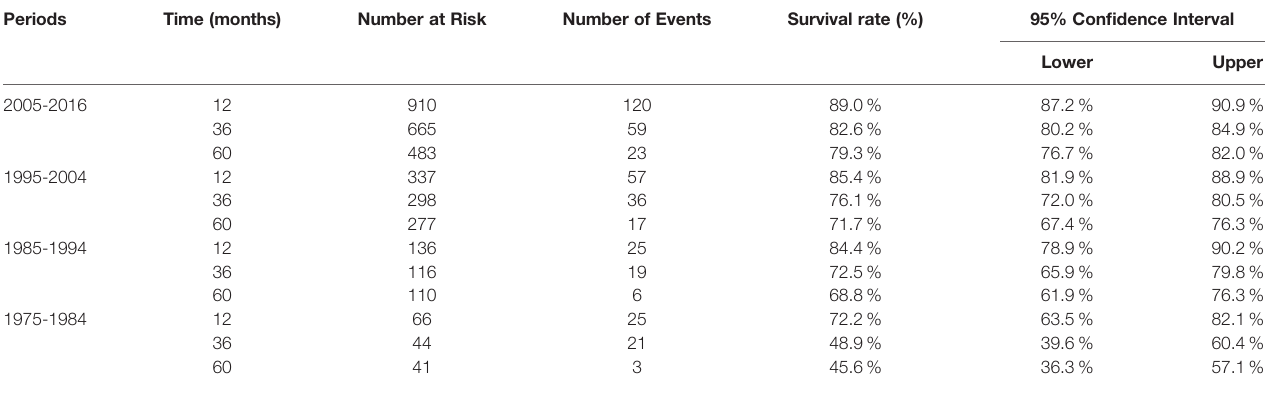
TABLE 3 | The 1-, 3-, and 5-year survival rates of pineal gland tumors in four periods. Periods Time